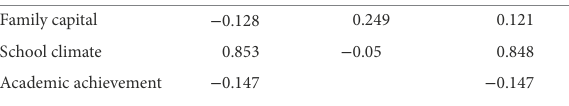
TABLE 8 Standardized effects on adolescent’ subjective well-being.